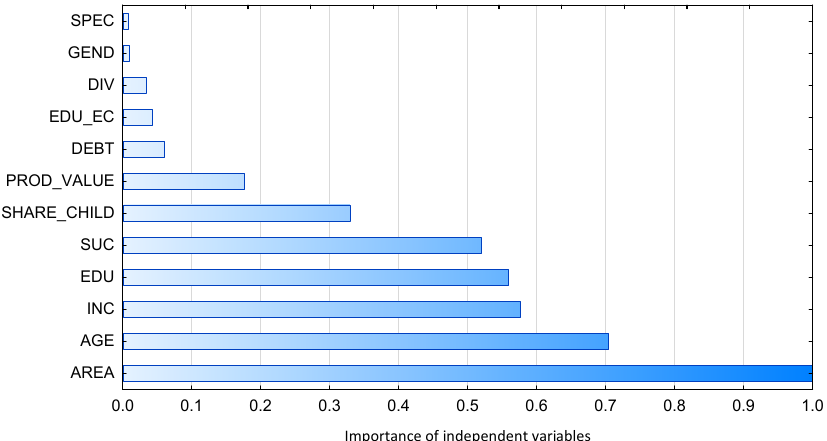
Figure 5. Importance of independent variables. Note: scale 0–1; 0—variable is not important; 1—variable is very important. Source: own study.